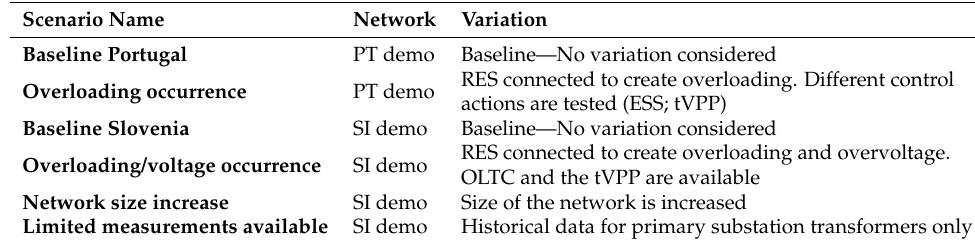
Table 1. Overview of the scenarios for Cluster